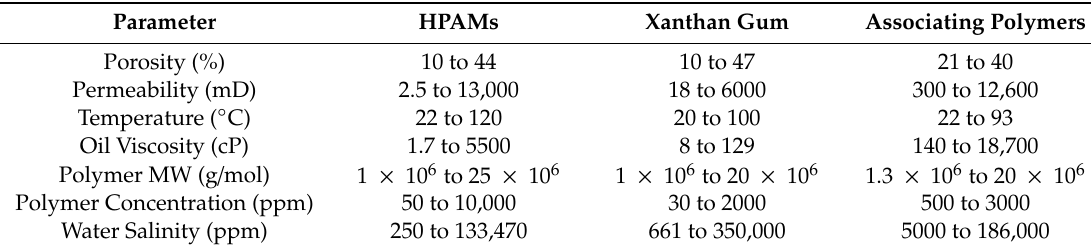
Table 3. Typical range of experimental conditions for lab-scale testing (data from